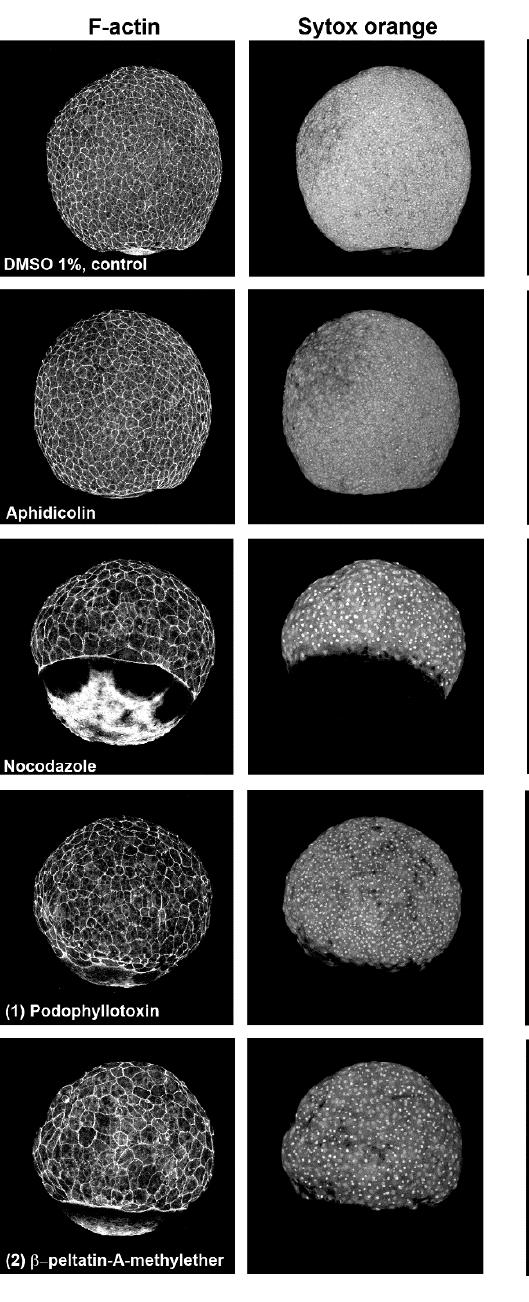
Figure 4. Immunolocalization of actin filaments and nuclei in zebrafish embryos after treatment with lignans ( 1 )–( 7 ), dimethyl sulfoxide (negative control), Aphidicolin, and Nocodazole (positive controls). Sphere-stage zebrafish embryos were treated with different compounds until control embryos reached 90% epiboly, fixed, processed for actin and nuclei staining, and visualized by confocal microscopy. Scale bar, 250 µ